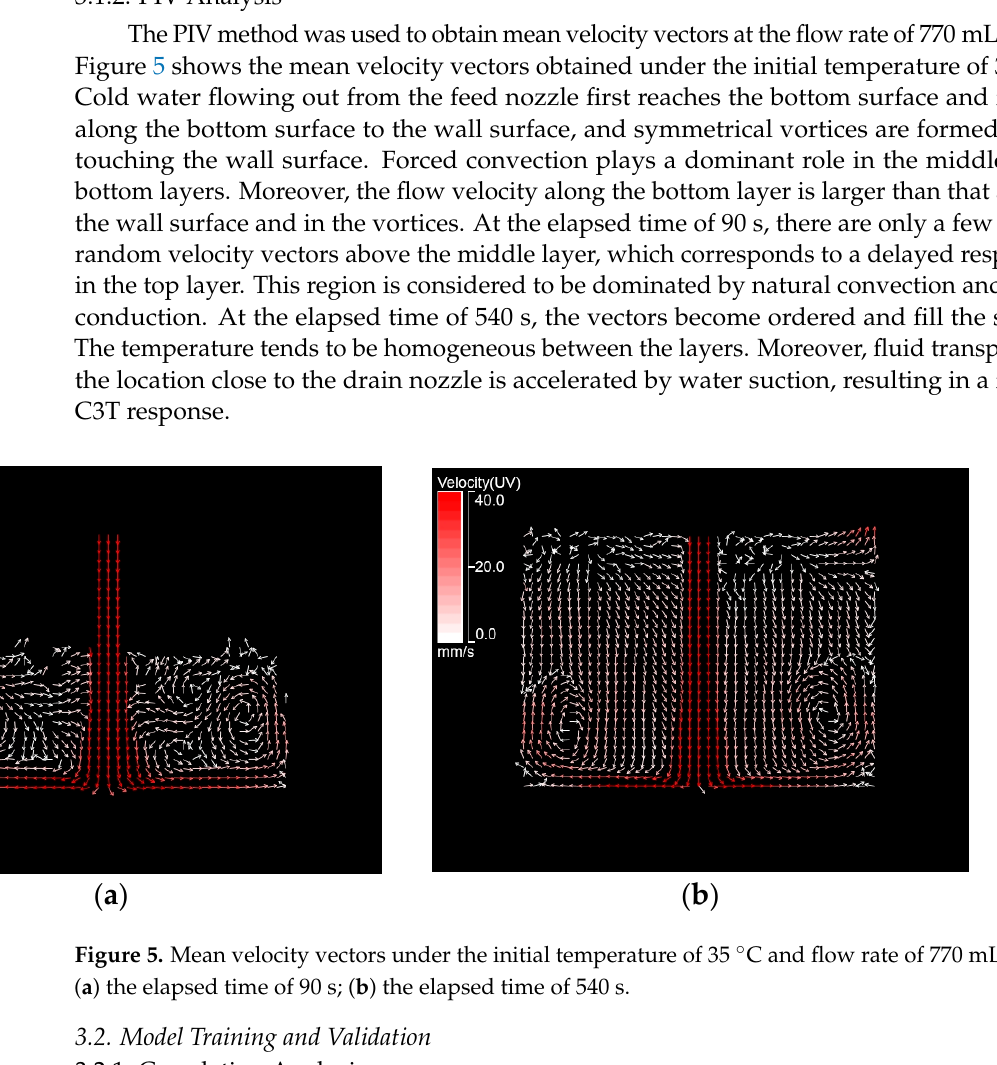
Figure 4. Temperatures variation comparisons between fl ow rates of 770 and 850 mL/min at the initial temperature of 35 °C: ( a ) top layer; ( b ) middle layer; ( c ) bo tt om layer.